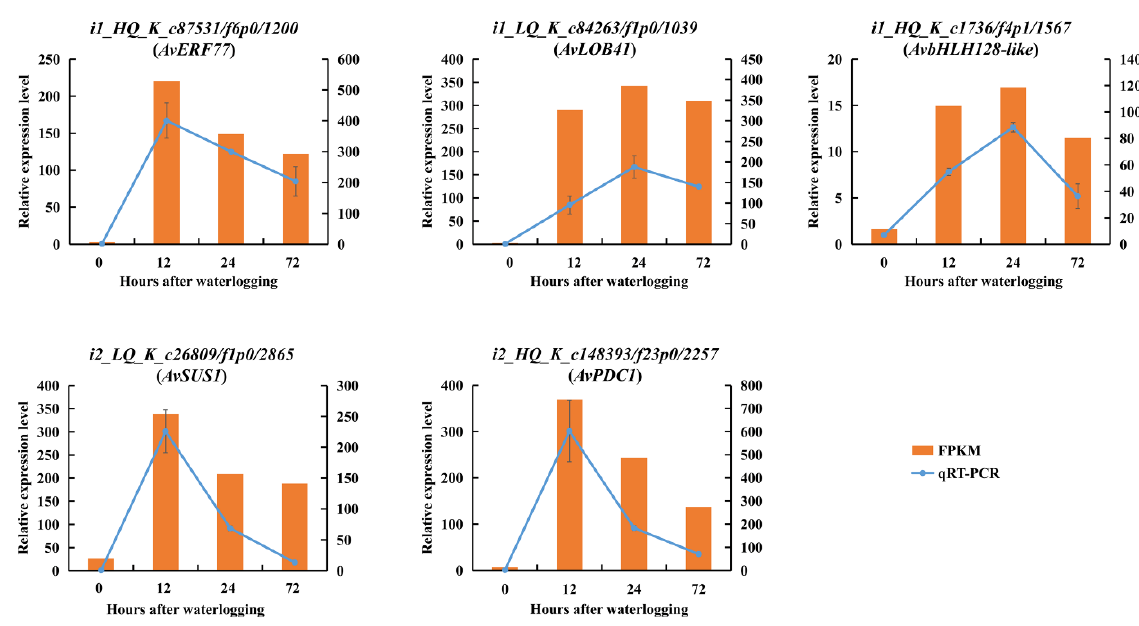
Figure 14. Expression patterns of several hub genes based on qRT-PCR (left vertical axis) and RNA- Seq (right vertical axis). Phylogenetic analyses of hub genes and their homologous genes were shown in Figure S6.